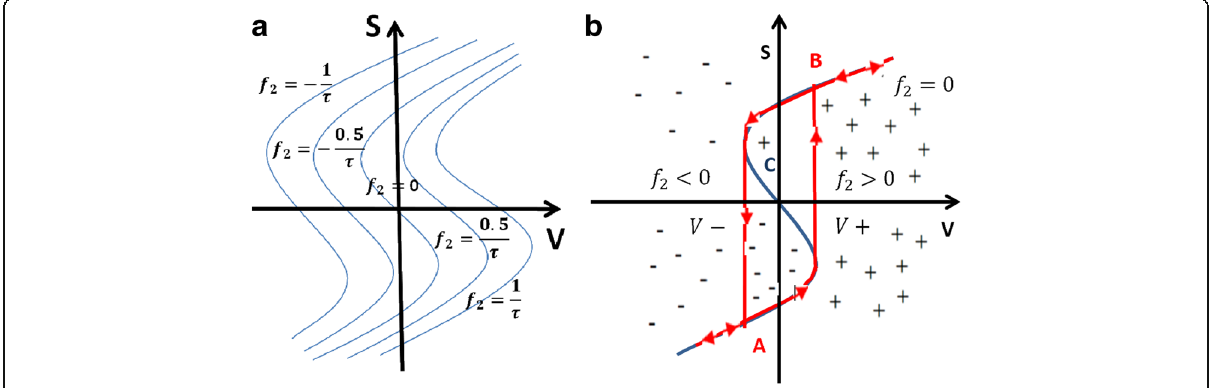
Fig. 23 f 2 function in (6) plotted in contour form and predicted s - v hysteresis curve depending on the sign of f 2